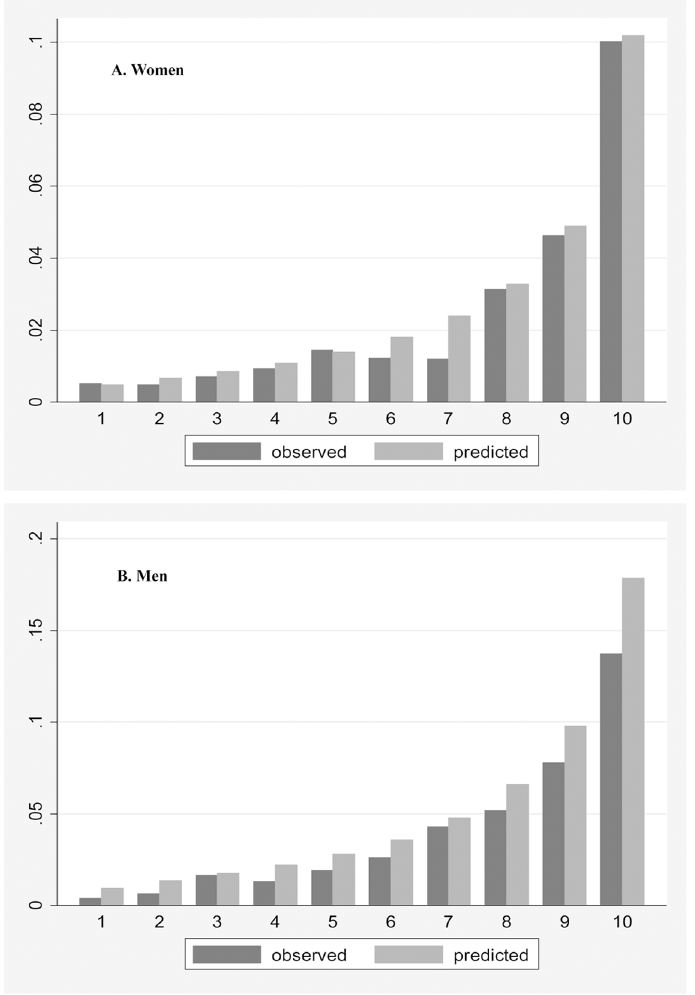
Fig 2. Ten-year predicted versus observed risk of CVD deaths in the Golestan Cohort Study participants. The X axis shows the deciles of predicted risks. The Y axis shows the mean